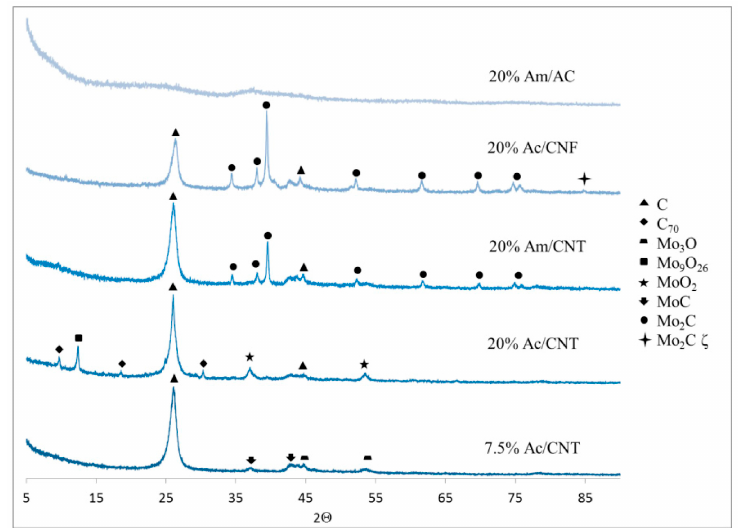
Figure 2. X-ray diffractograms of representative catalysts showing different crystalline phases, Reproduced from [39].